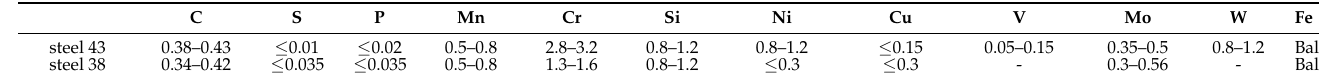
Table 2. Chemical composition of steel 43 and steel 38.